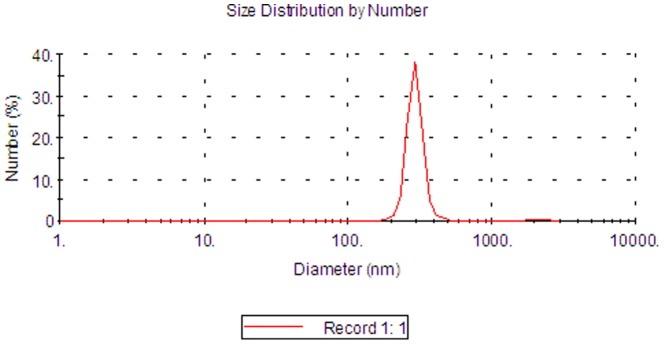
Hydrodynamic diameter distribution of TiO2 NPs in HPMC using DLS characterization.